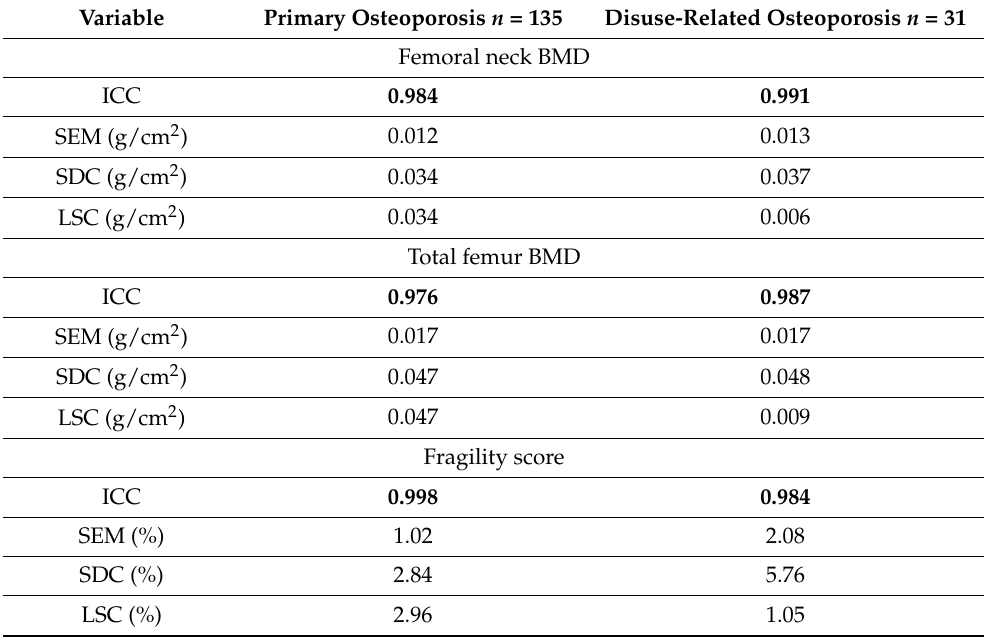
Table 2. REMS reproducibility results. BMD: bone mineral density; ICC: intraclass correlation coefficient (all ICCs were statistically significant and are highlighted in bold); SEM: standard error of measurement; SDC: smallest detectable change; LSC: least significant change.